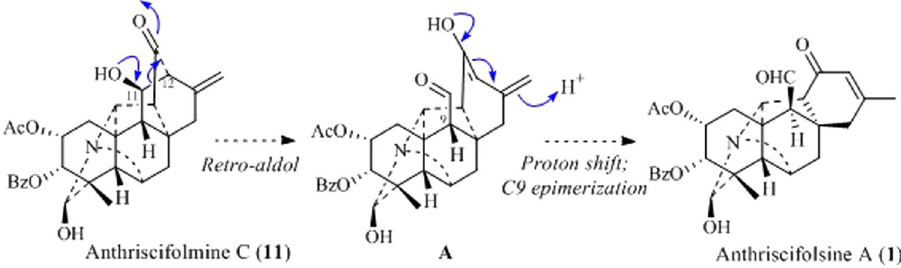
Figure 5. Postulated biogenetic pathway of anthriscifolsine A ( 1 ).